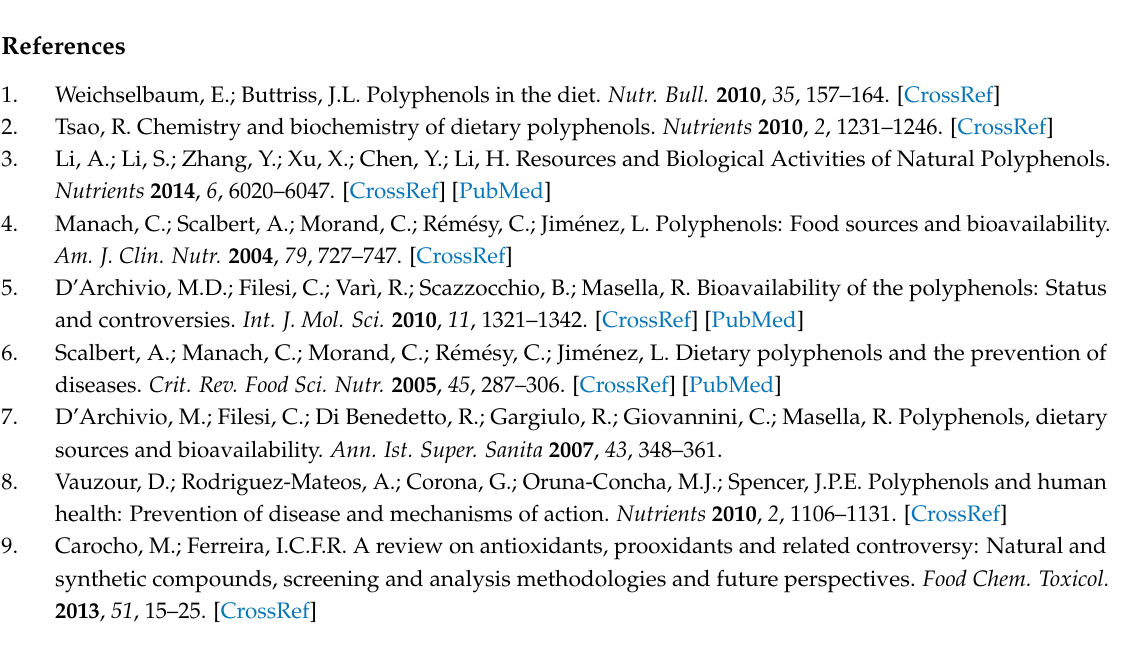
Supplementary Materials: The Supplementary Materials are available online, Table S1: Desorption stability of protein–phenolic complexes affected by pH and ionic